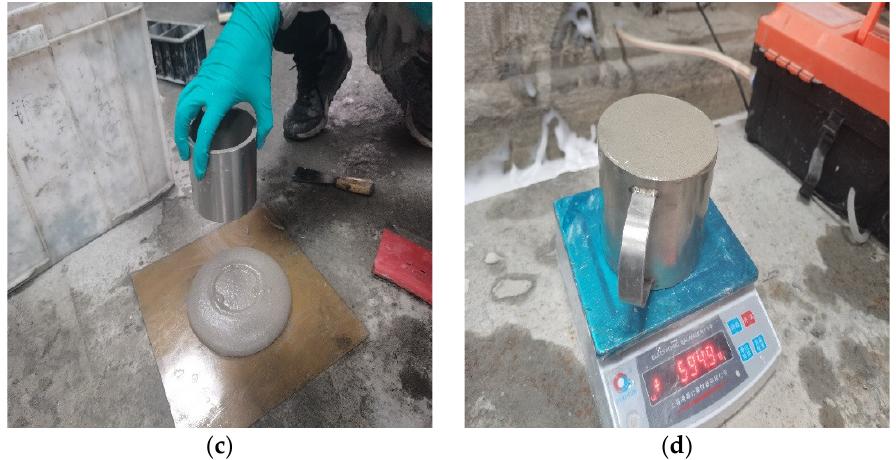
Figure 2. Preparation of FLS specimens: ( a ) foam preparation, ( b ) measurement of foam density, ( c ) measurement of FLS flow factor, and ( d ) measurement of FLS wet density.